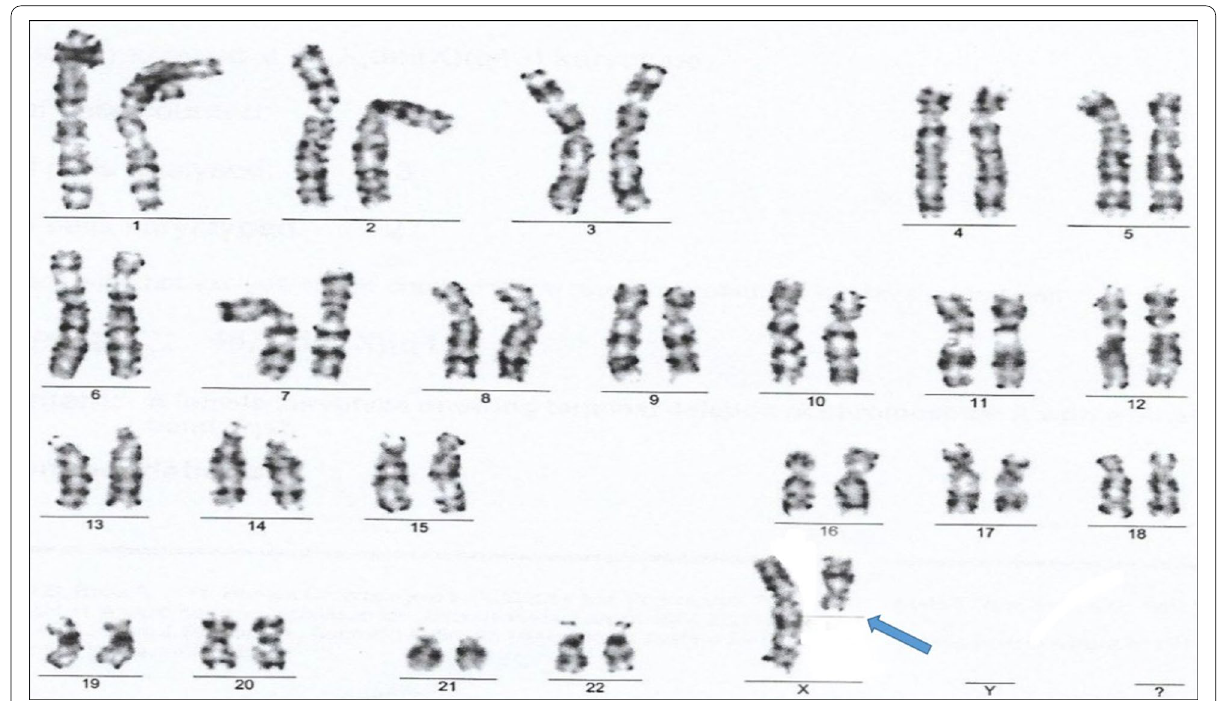
Fig. 1 Female karyotype with partial deletion of the long arm of an X chromosome with a break in band Xq13